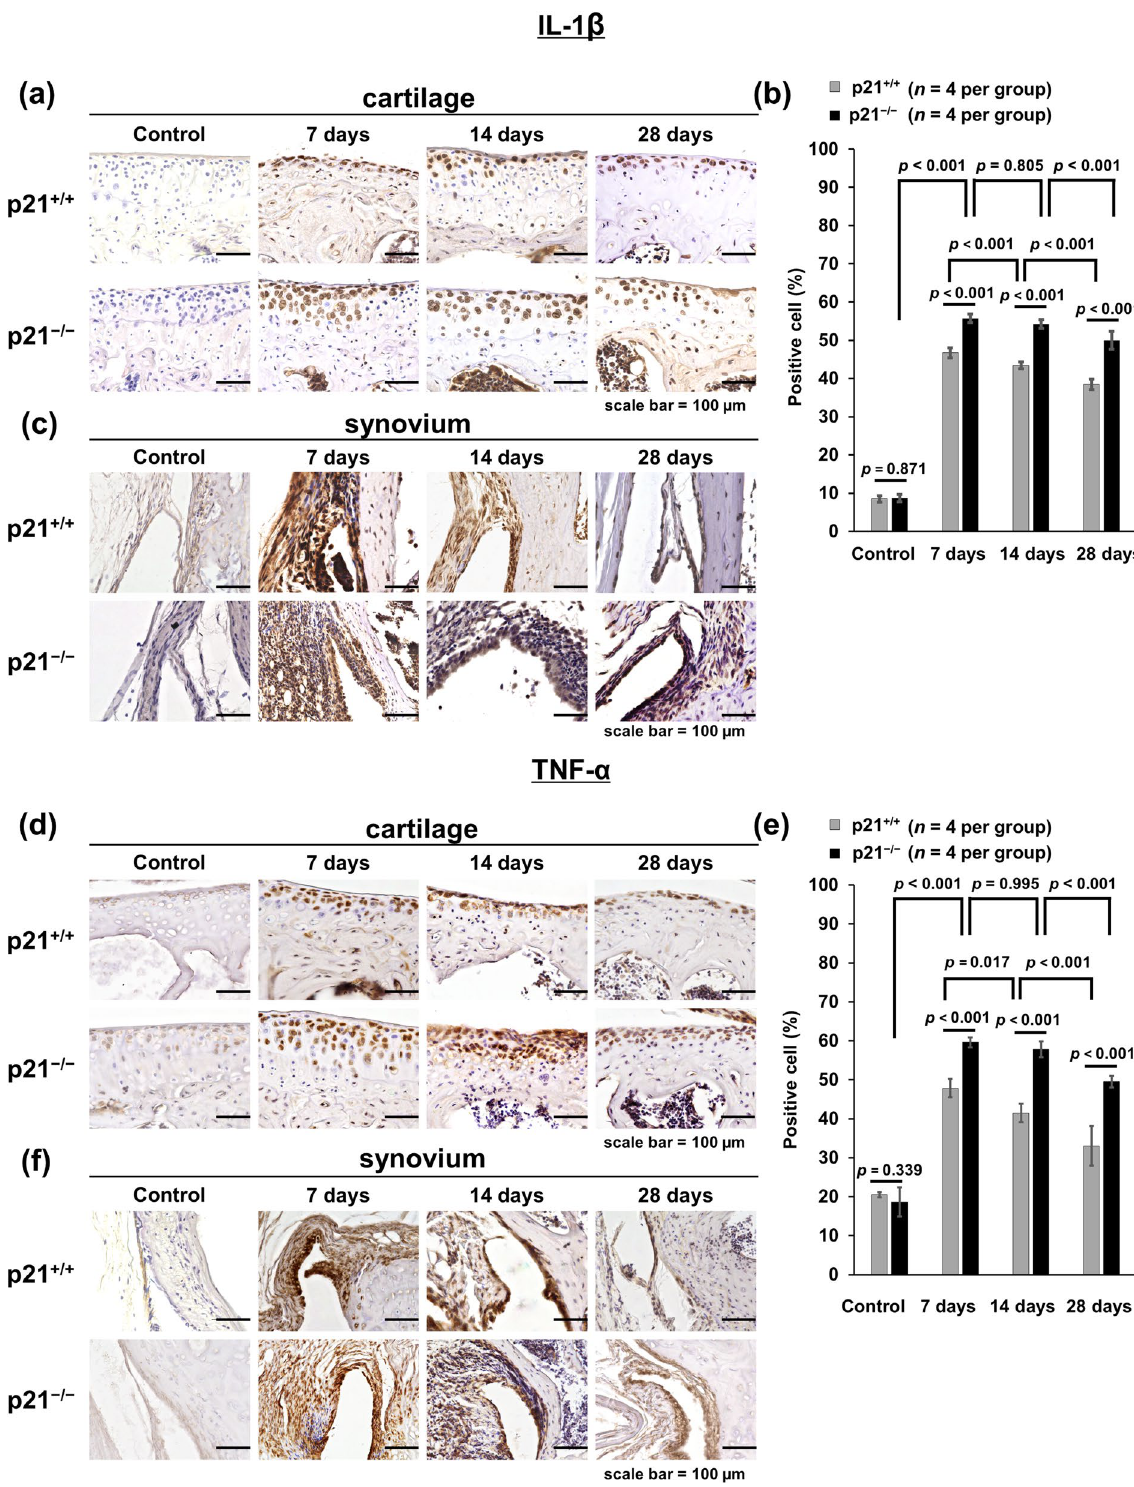
Figure 2. p21 levels influence the number of IL-1β and TNF-α positive cells in the CAIA mouse model. ( a,d ) Cartilage and ( c,f ) synovial tissue samples were collected from the knees of mice after antibody cocktail administration. ( a,c,d,f ) p21 +/+ mice and p21 −/− mice as control, on days 7, 14, and 28. ( b ) The percentage of IL-1β-stained cells (number of positive cells/total number of cells) with 95% CI. The sections were counterstained with hematoxylin. ( e ) The percentage of TNF-α-stained cells (number of positive cells/total number of cells) with 95% CI. In ( b,e ), four mice were analyzed from each group. Two-way analysis of variance and Tukey’s post hoc test for multiple comparisons of paired samples were used. CI confidence interval, CAIA collagen antibody-induced arthritis, p21 cyclin-dependent kinase inhibitor